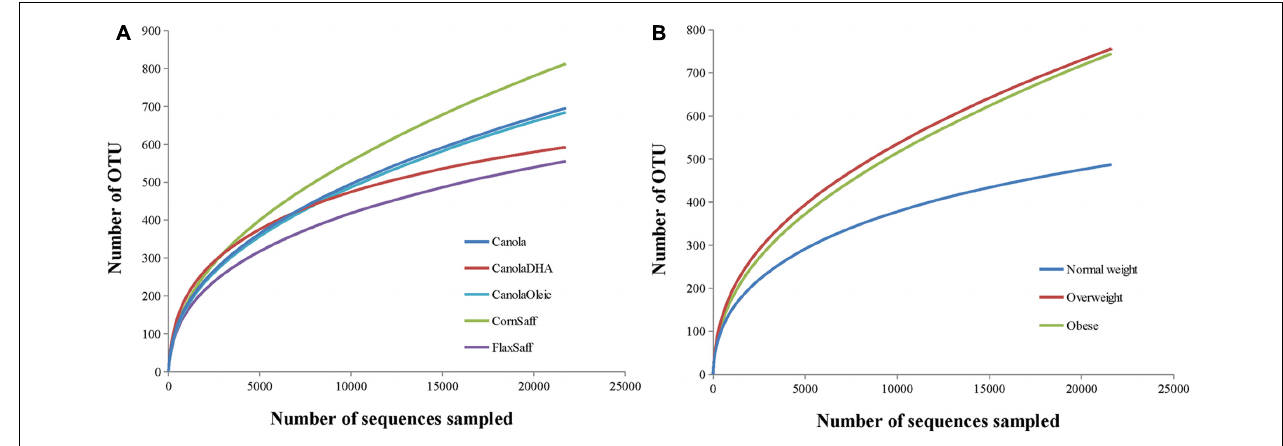
FIGURE 1 | (A,B) Rarefaction analysis for the observed species. The rarefaction curve is generated using Chao1 richness estimator according to oil treatments (A) or subjects’ body mass index (BMI; B ). Samples have been rarified at an even depth of 21,000 sequences per oil treatment or BMI group.